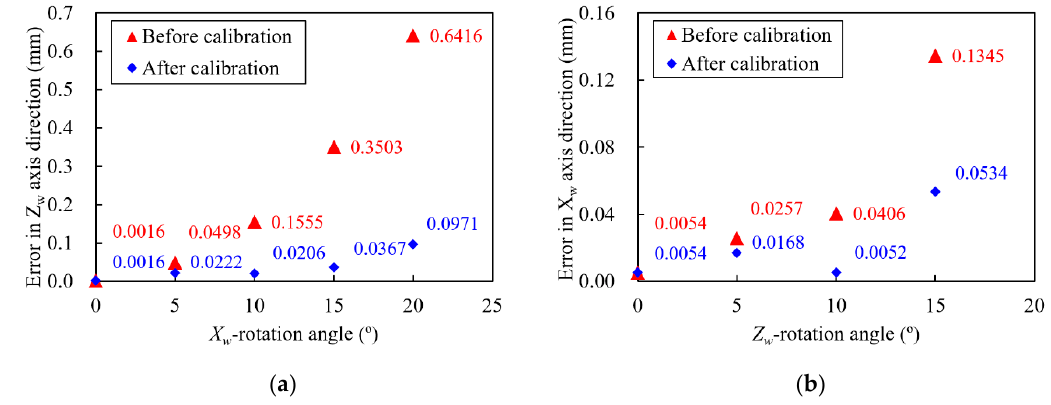
Figure 8. Calibration results of the ( a ) X w and ( b ) Z w rotation errors.